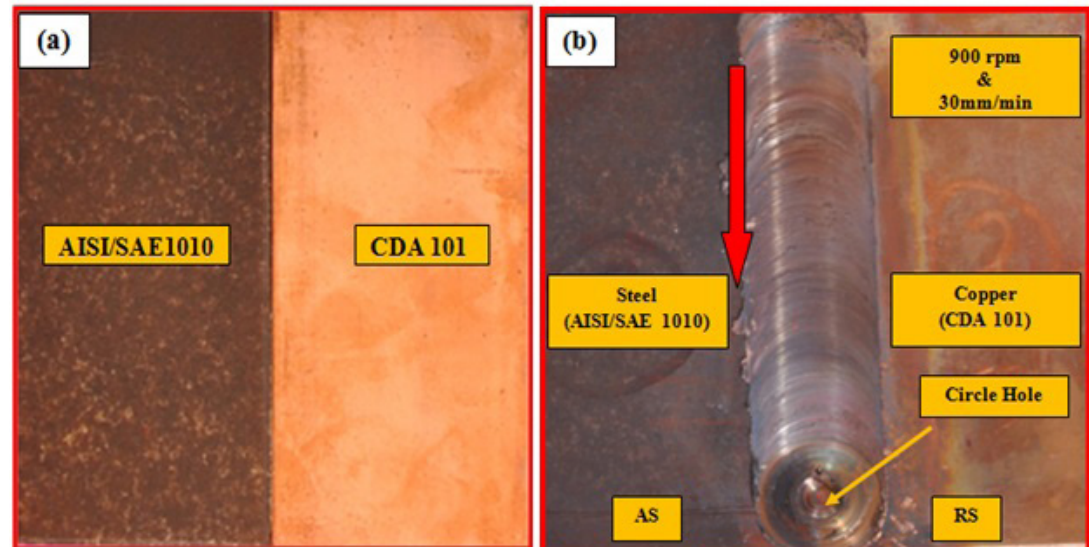
Figure 3. Before and after welding copper and steel plates. (a) Before welding; (b) After